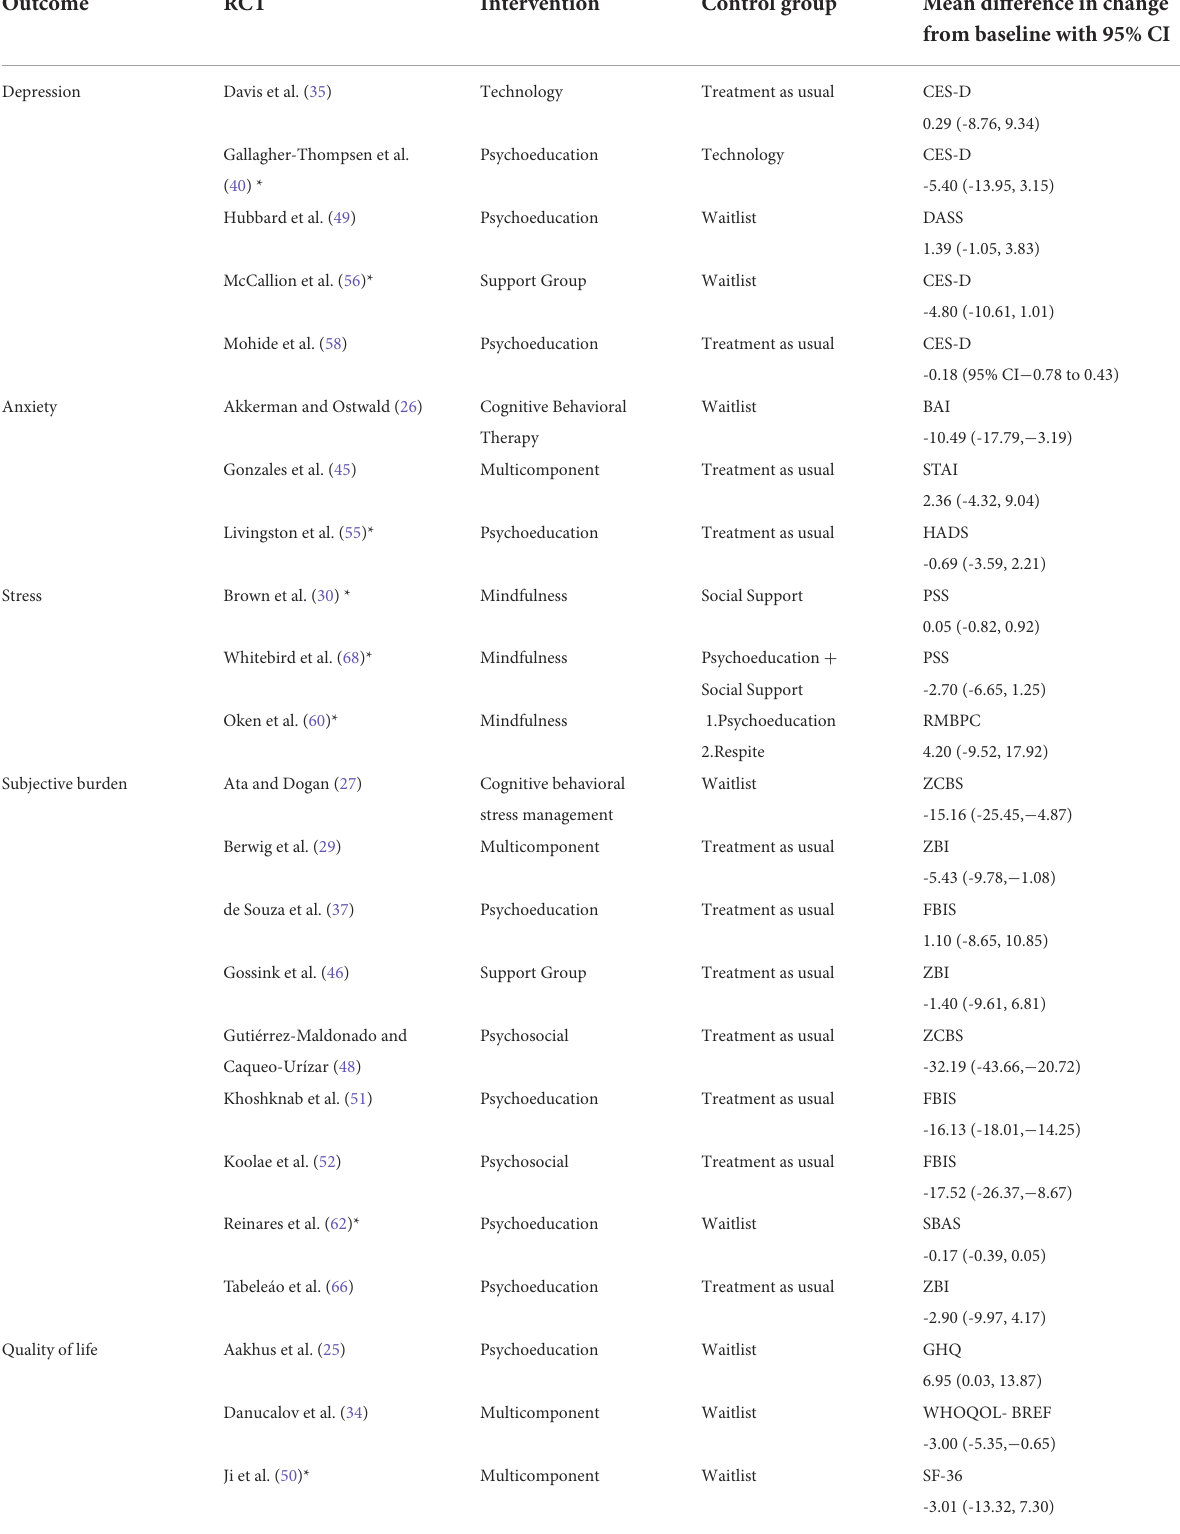
TABLE 2 Mean difference in change from baseline in the specific outcomes of psychological distress included in the meta-analysis. Outcome RCT Intervention Control group Mean difference in change